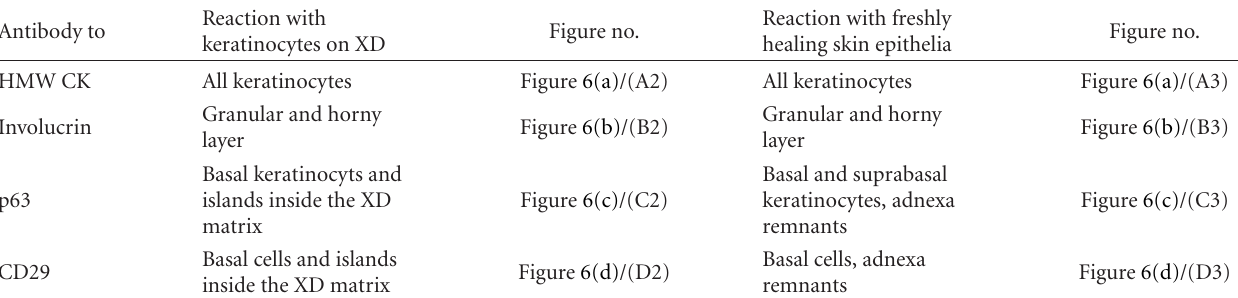
Table 1: Keratinocyte di ff erentiation in vitro and in vivo . Figure no. Figure